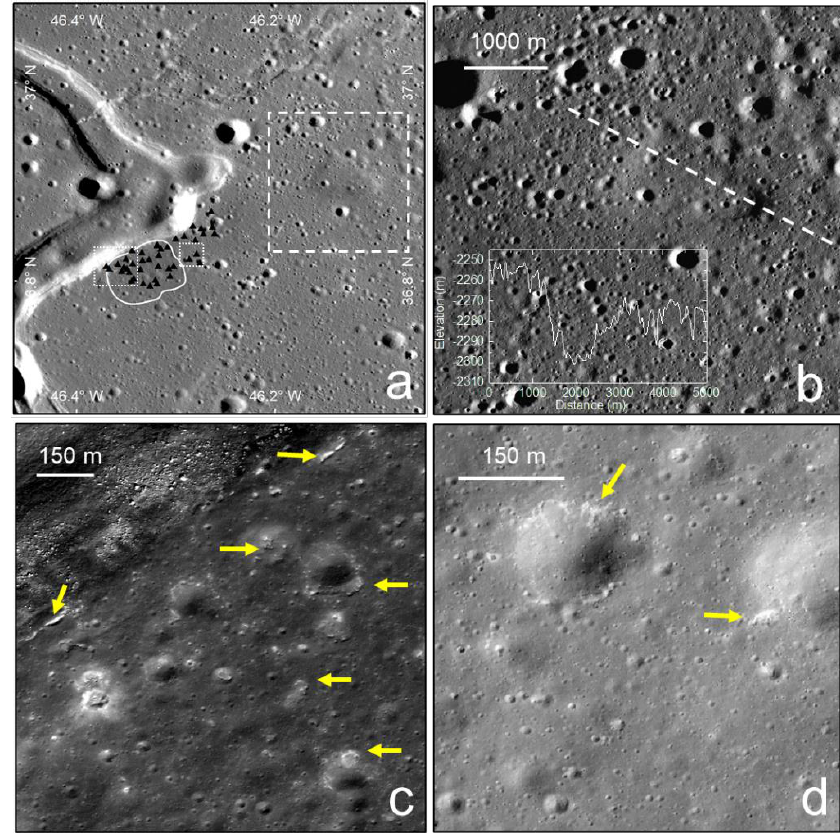
Figure 5. The gas-related volcanic features near the vent of Rima Mairan. ( a ) The full view of the location, with black triangle marking the irregular mare patches (IMPs), the white dashed box marking the location of ( b ), and the dotted box is ( c ) and ( d ) from left to right, respectively; ( b ) is an irregular volcanic depression/pit. ( c , d ) Some IMPs annotated by yellow arrows.